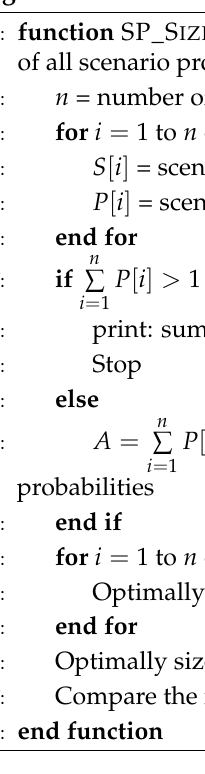
Algorithm 1 Calculating the solution after averaging the